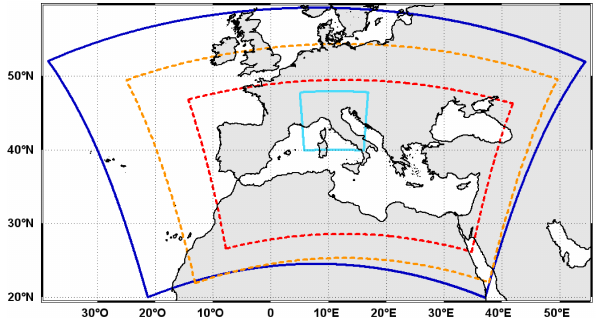
Figure 2. Computational domains for the meteorological compo- nent of the operational SIMM, namely the 0.3 ◦ BOLAM (orange long-dashed line) and the 0.1 ◦ BOLAM (red long-dashed line), and of the HyMeX-based SIMM, namely the 0.07 ◦ BOLAM (blue solid line) and the 0.0225 ◦ MOLOCH (sky blue solid